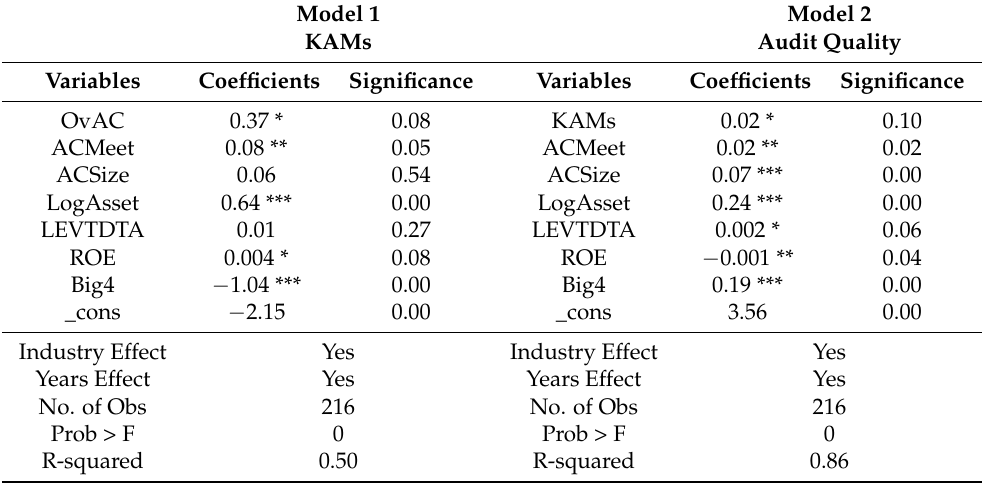
Table 3. Regression